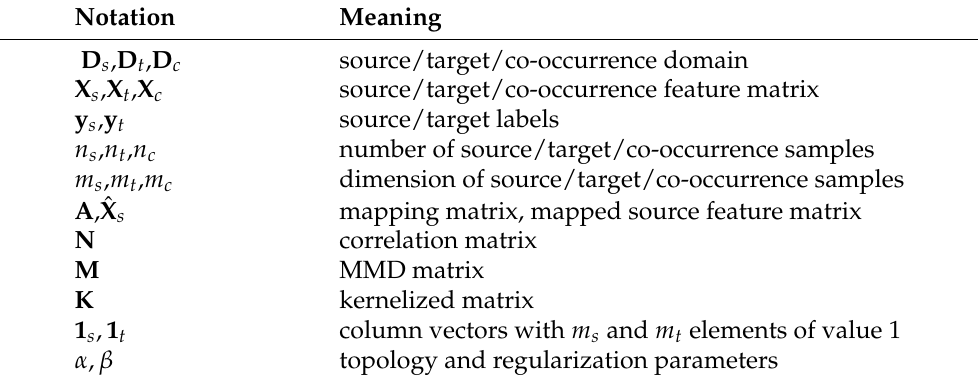
Table 1. Abbreviation